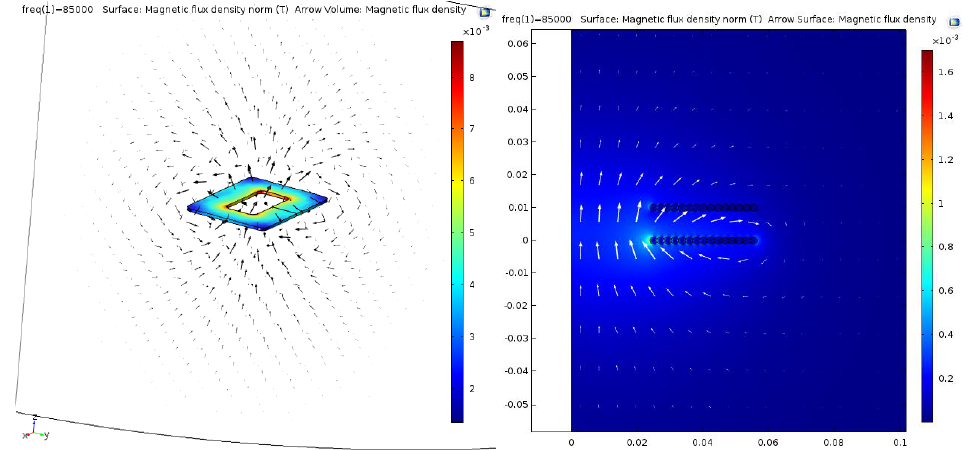
Figure 9. FEM simulation models of the rectangular coil (top-left), circular coil (top-right) and the rectangular coil (bottom) couple. The rectangular coils are modeled in the 3D domain, while the circular coils due to their rotational symmetry are modeled in the 2D domain.